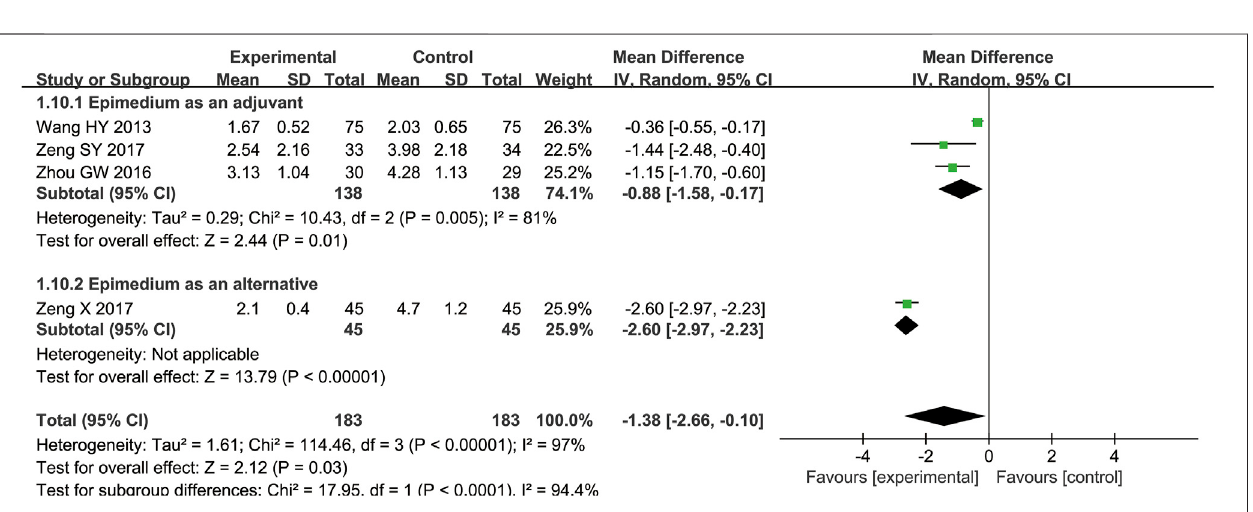
Frontiers in Pharmacology |